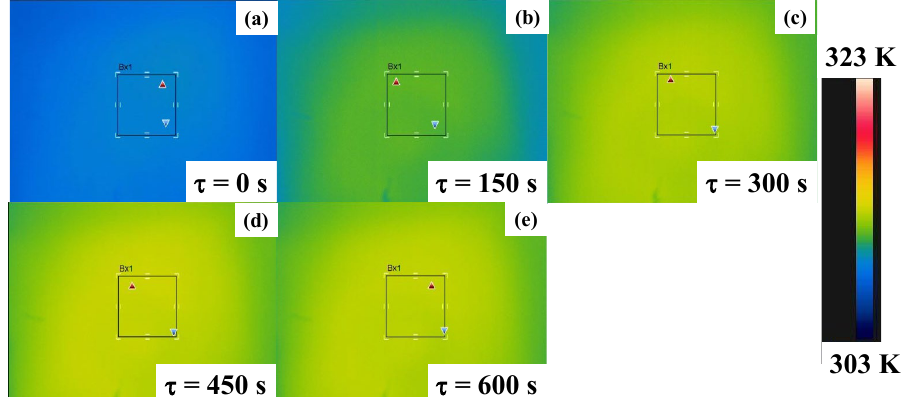
Figure 12. Time evolution of the temperature distribution on the top surface of BC-PC plate by the measurement through the thermography. ( a ) Initial temperature, ( b ) τ = 150 s, ( c ) τ = 300 s, ( d ) τ = 450 s, and ( e ) τ = 600 s.